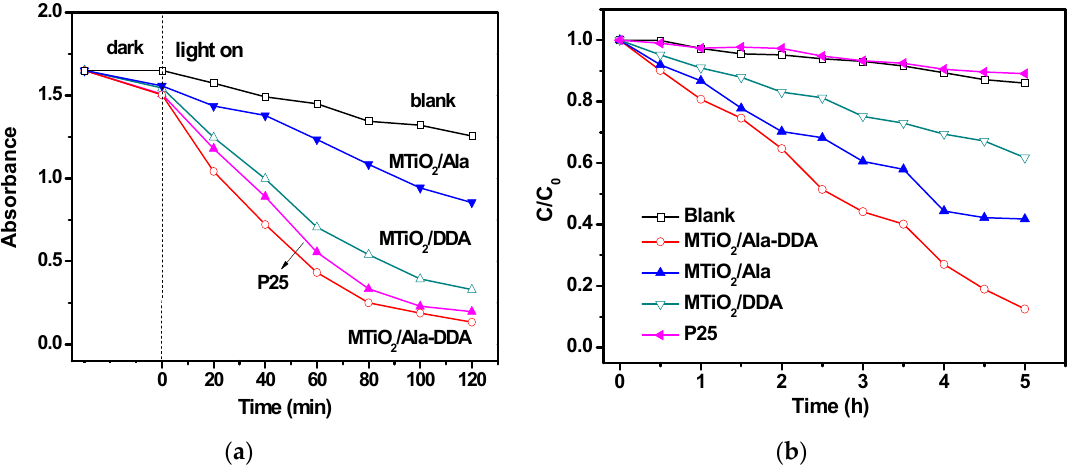
Figure 8. A comparison of the photoactivities of MTiO 2 / Ala-DDA, MTiO 2 / DDA, MTiO 2 / Ala, and blank experiment (without catalyst) under ( a ) UV light and ( b ) visible light.